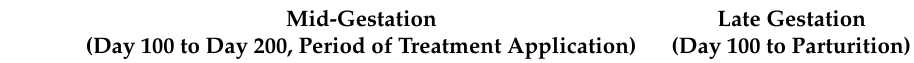
Table 1. The chemical composition of the feedstuffs in both experimental replicates (expressed in the table as the mean ± standard